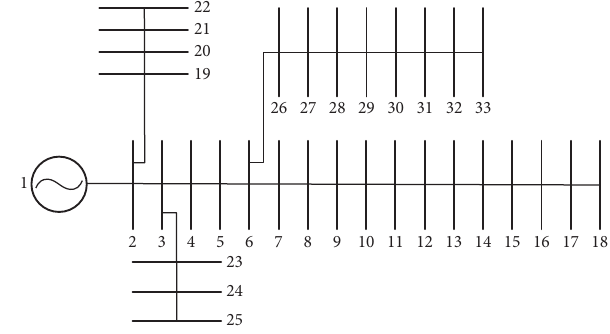
Figure 2: IEEE 33-bus distribution network.